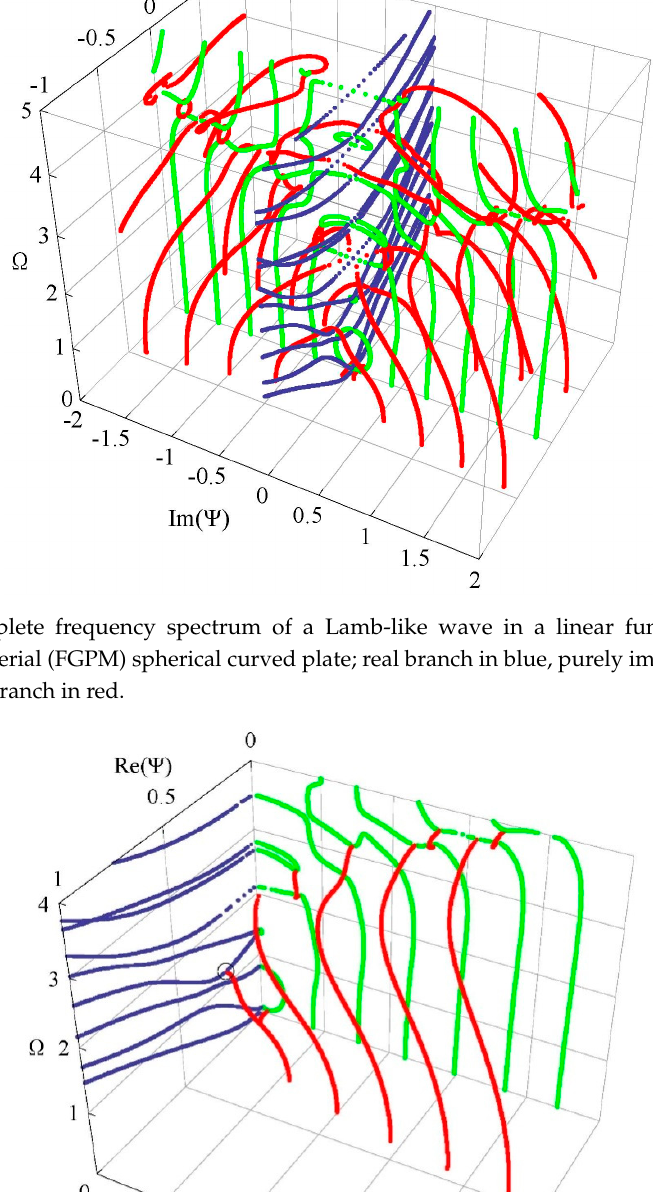
( b ) Figure 6. Frequency spectrum of a Lamb-like wave: ( a ) first quadrant curves; ( b ) 2D projection curves. Figure 7 shows the phase velocity dispersion and attenuation curves of the first few real and complex branches. The dimensionless phase velocity and frequency and wave number are defined by